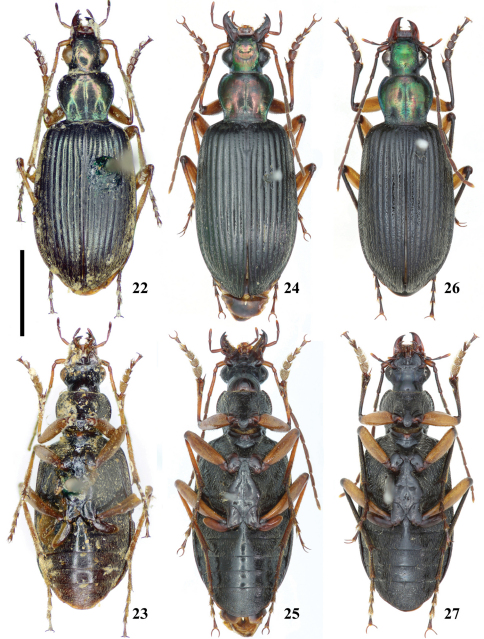
Habitus ofChlaenius (Lithochlaenius) spp22 Chlaenius agilis Chaudoir, holotype, dorsal view23 Chlaenius agilis Chaudoir, holotype, ventral view24 Chlaenius formosensis Lorenz, male, in CCCC, dorsal view25 Chlaenius formosensis Lorenz, ventral view26 Chlaenius leishanensis Kirschenhofer, male, in IZCAS, dorsal view27 Chlaenius leishanensis Kirschenhofer, male, in IZCAS, ventral view. Scale line = 5.0 mm.